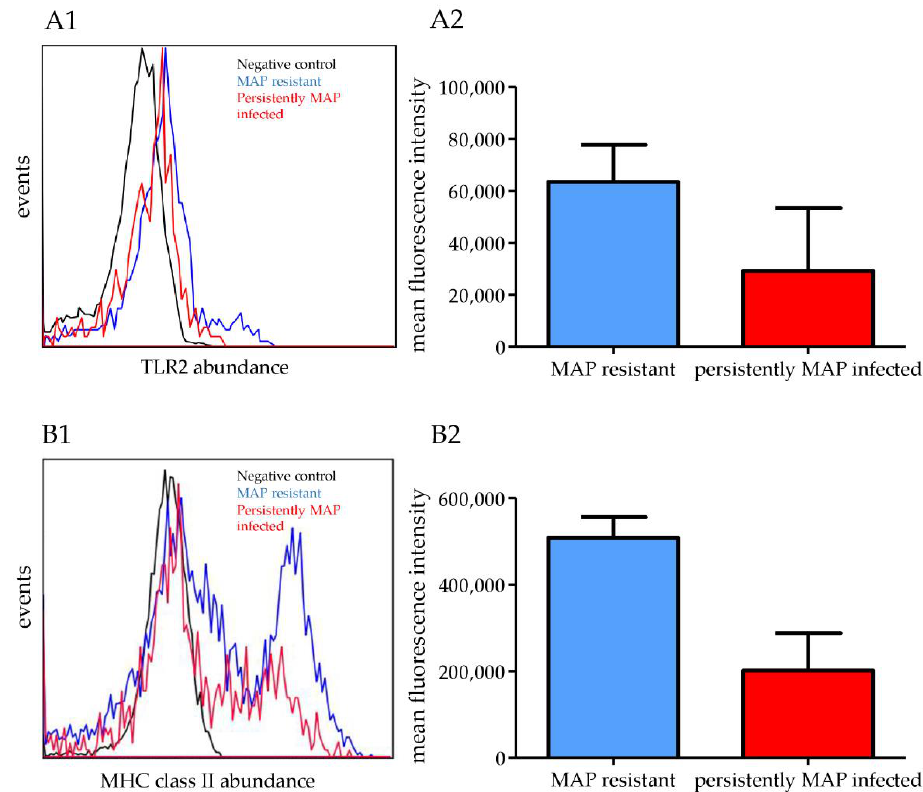
Figure 2. Higher abundance of TLR2 and MHC class II in PBMC of MAP-resistant compared with persistently MAP-infected cows. ( A1 ) Higher abundance of TLR2 in PBMC from MAP-resistant compared with persistently MAP-infected cows as measured by flow cytometry analysis with representative histograms. ( A2 ) Higher mean fluorescence intensity of TLR2 positive PBMC from MAP-resistant compared to persistently MAP-infected cows. Mean fluorescence intensity from flow cytometry ± SD ( B1 ) Higher MHC class II abundance in PBMC from MAP-resistant compared with persistently MAP-infected cows as measured by flow cytometry analysis with representative histograms. ( B2 ) Higher mean fluorescence intensity of MHC class II positive PBMC from MAP-resistant compared to persistently MAP-infected cows. Mean fluorescence intensity from flow cytometry ±